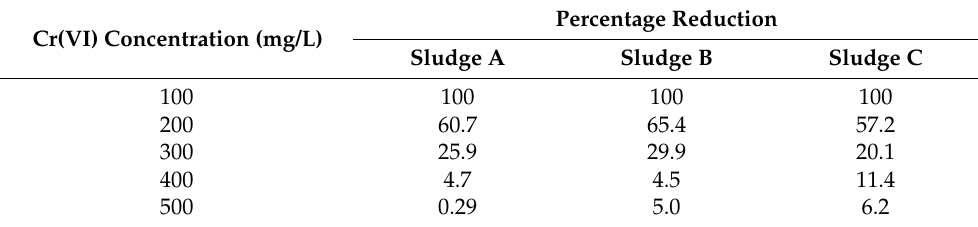
Table 1. % Cr(VI) reduction by microbial consortia from primary sludge (sludge A), activated sludge (sludge B), and dry sludge (sludge C) under different initial Cr(VI) concentration incubated for 24 h. Cr(VI) Concentration